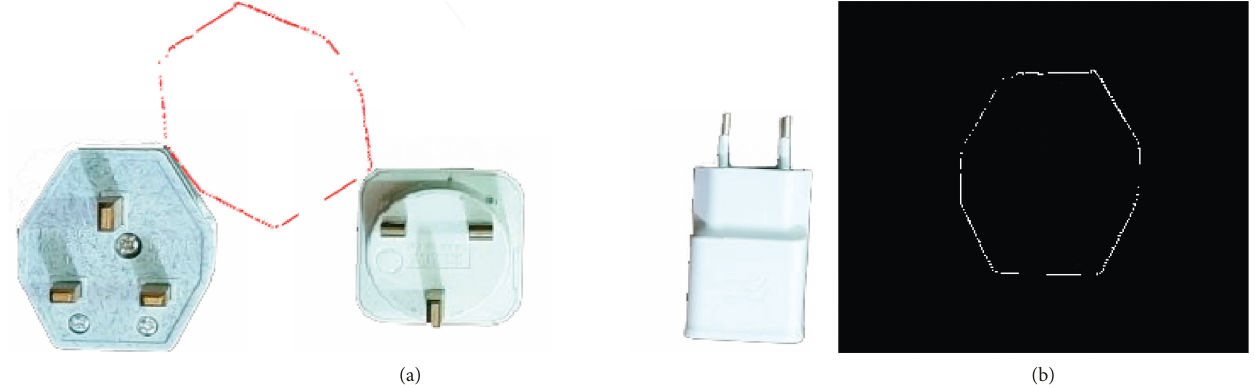
Figure 11: The matching of Roberts edge method: (a) product image captured; (b) template image.